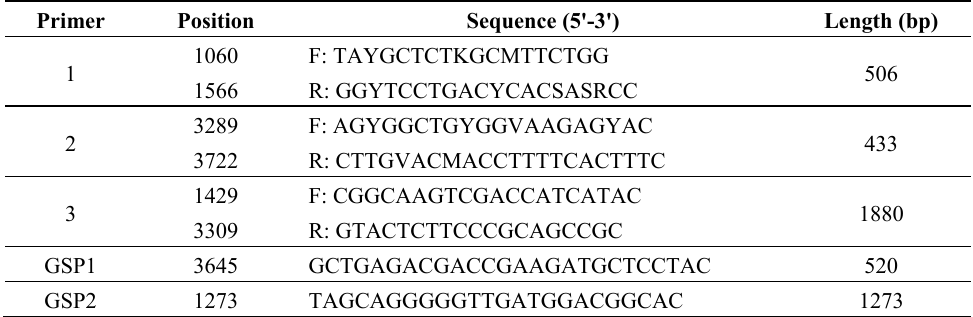
Table 2. Location and sequence of primers used for the molecular cloning of PxPgp1